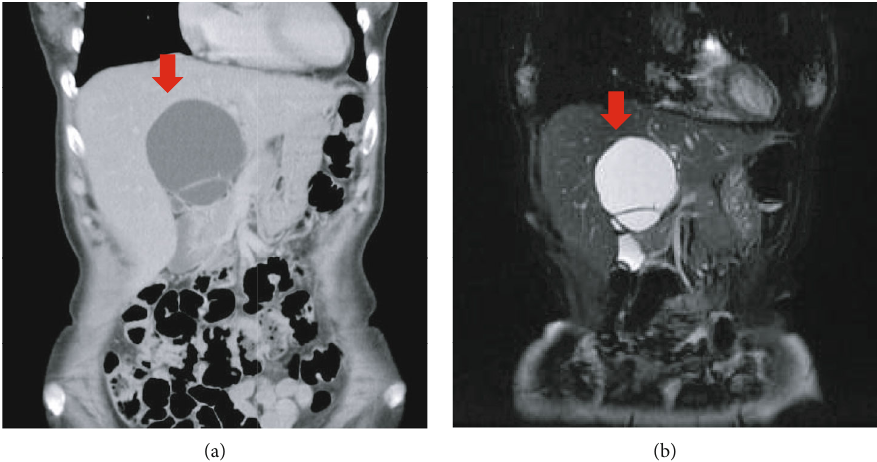
Figure 3: (a) Enhanced computed tomography and (b) T2-weighted magnetic resonance imaging at regrowth 6 months after deroo fi ng showed cystic lesions with septations arising from the cyst wall without indentation (red